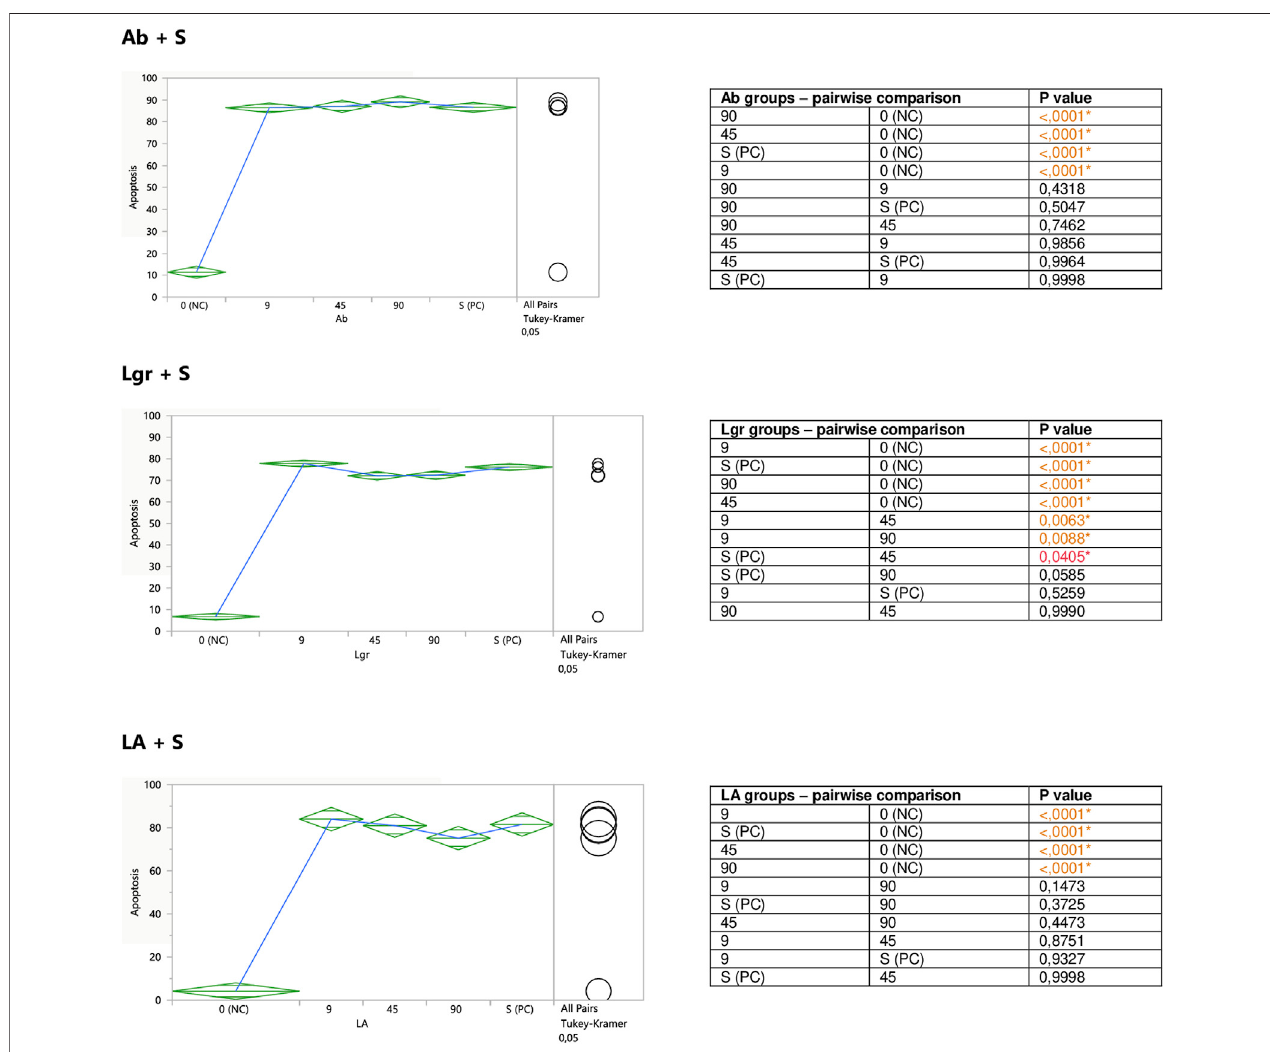
FIGURE 8 | Modulatory effect of Ab, Lgr, and LA on staurosporine-induced apoptosis of Jurkat cells. 0 (NC) = negative control (untreated Jurkat cells); S (PC) = positive control (Jurkat cells treated with staurosporine); 9, 45, and 90 = Jurkat cells incubated with a given (poly)phenol at the concentration of 9, 45, or 90 μ M, and subsequently treated with staurosporine. Apoptosis = per cent of apoptotic cells. Means diamonds illustrate ANOVA analysis (upper and bottom points are at 95% con fi dence points of each group). The circles on the right express signi fi cant differences between group means (if they do not overlap), or the lack of signi fi cant differences (if they